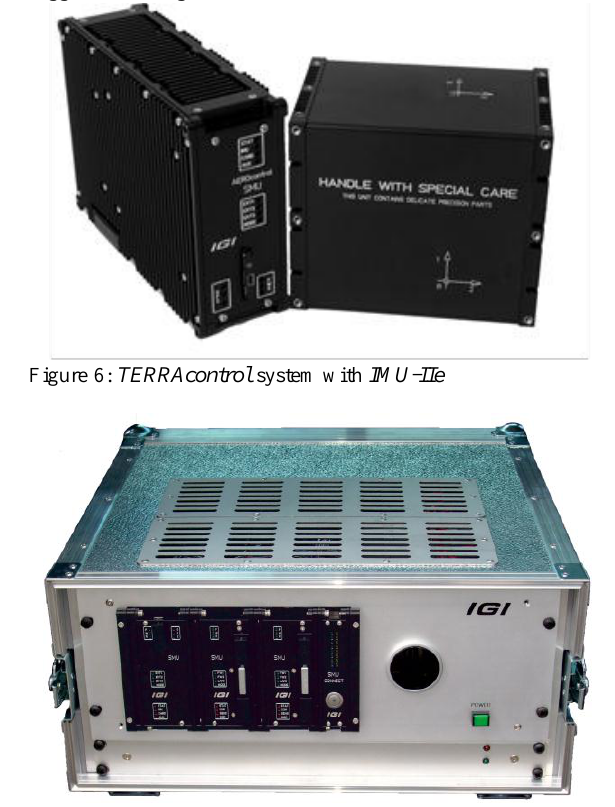
Figure 7: RailMapper control rack